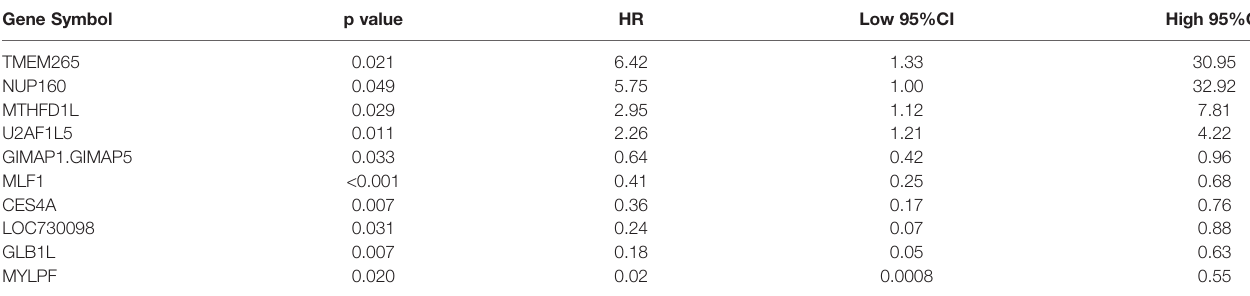
TABLE 2 | Univariate analysis of the relationship of gene expression with OS in NPC. Gene Symbol p